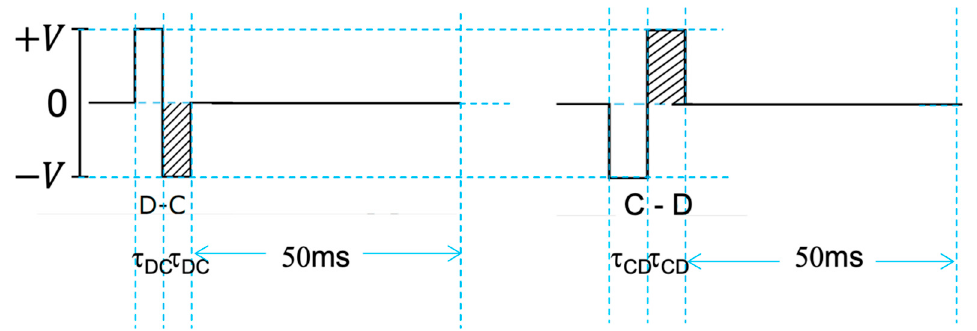
Figure 8. Schematic of the waveforms applied to latch between states, from D to C and from C to D. Shading indicates the latching pulse.